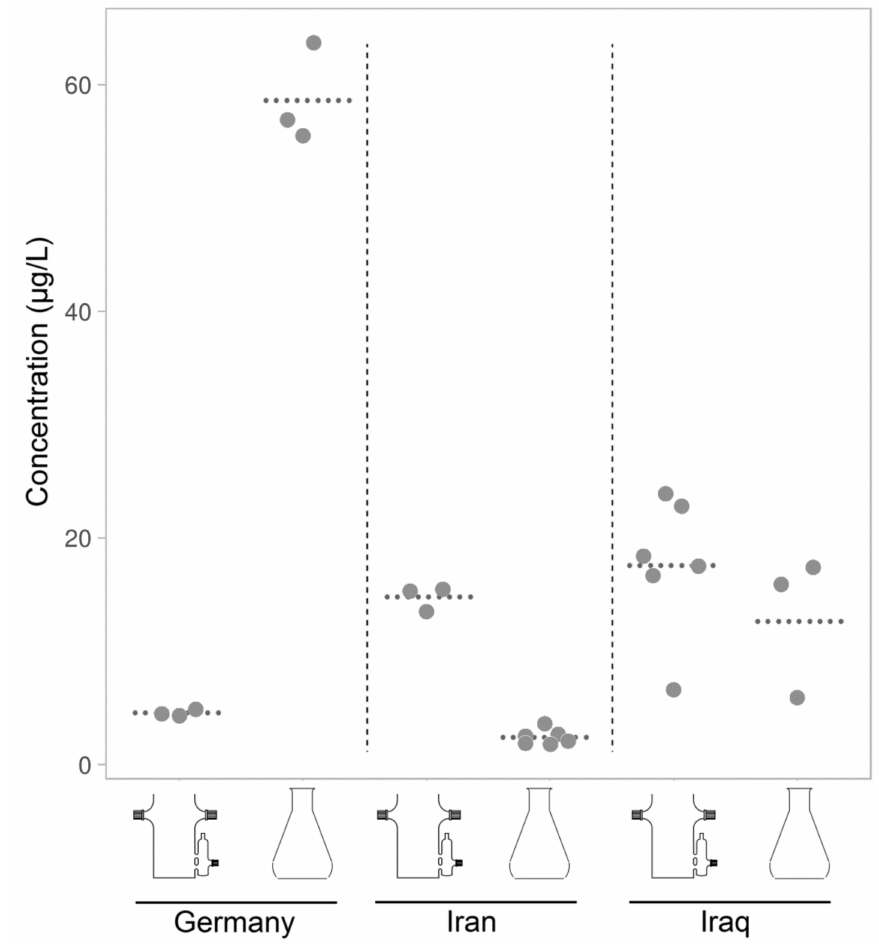
Figure 9. Salicylic acid accumulated in nutrient solution of hairy root cultures derived from three accessions of Hyoscyamus niger (designated Iraq, Iran and Germany) and grown in bioreactors and in shaking flasks for three weeks. Dotted lines show the